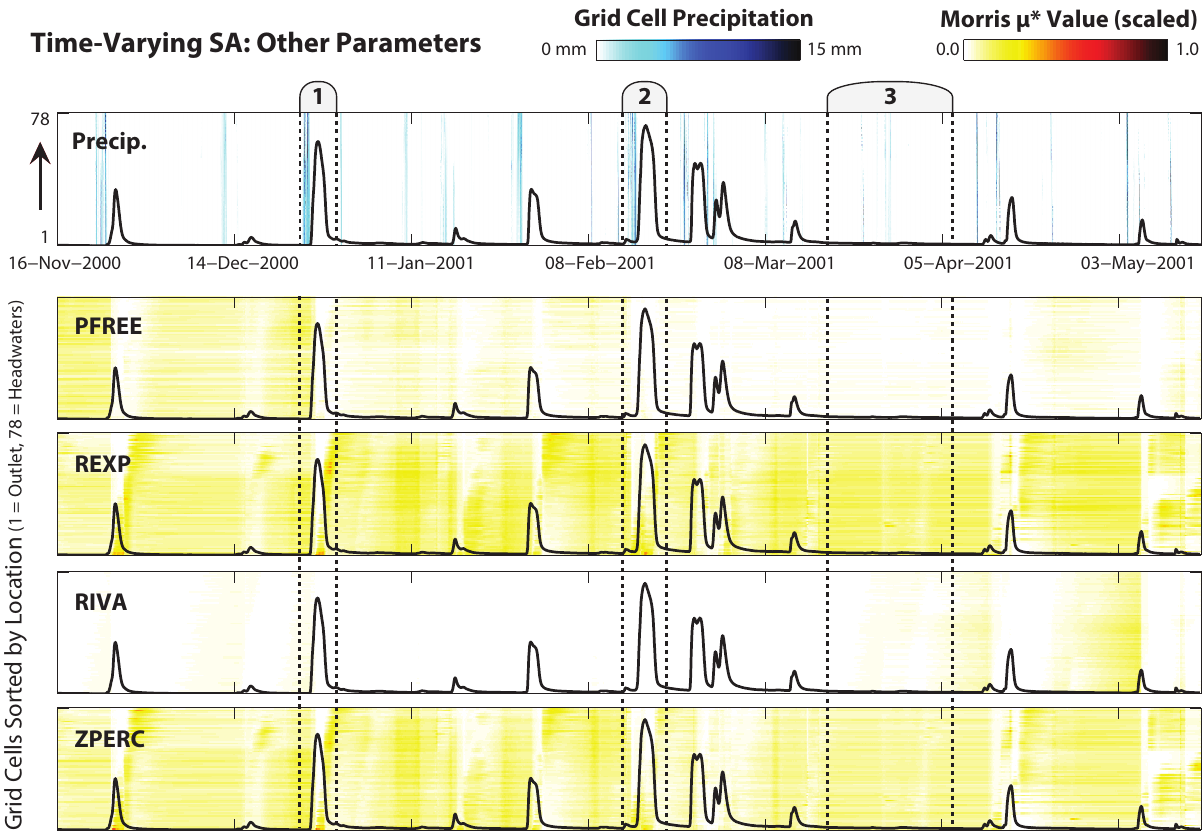
Fig. 8. Time-varying sensitivity of the RMSE metric for the four remaining parameters of the HL-RDHM model. The indices are calculated for a 24-hour moving window with a 3-hour timestep. The y -axis arranges the 78 grid cells based on their distance from the watershed outlet, from the outlet ( y = 1 ) to the furthest headwater cell ( y = 78 ). The µ ∗ values from the method of Morris are scaled to the range [0 , 1] from an initial range of [0 , 0 . 2] . These parameters influence model performance significantly less than the lower zone parameters (Figure 6) or the upper zone parameters (Figure 7), and never appear highly sensitive during the course of the simulation.